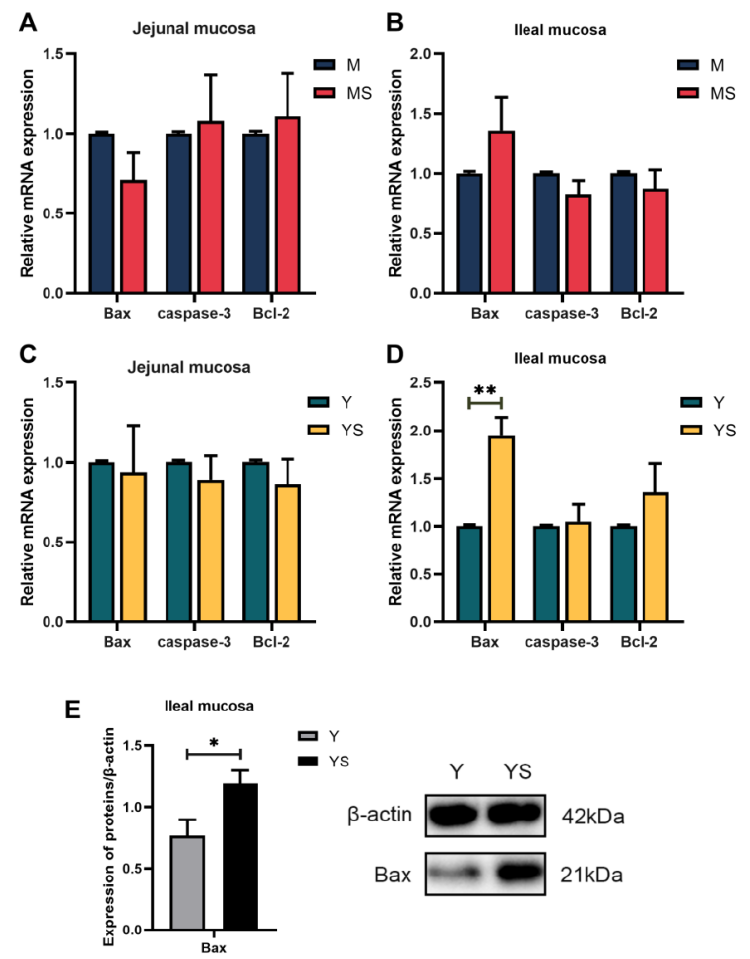
Figure 5. Effects of chronic cold stress on the expression of key genes and proteins in the apoptotic pathway of pig intestinal mucosa. ( A , B ) The mRNA expression of key genes of apoptosis in intestinal mucosa of Min pigs (n = 6). ( C , D ) The mRNA expression of key genes of apoptosis in intestinal mucosa of Yorkshire pigs (n = 6). ( E ) The protein expression level of Bax in the ileal mucosa of Yorkshire pigs (n = 6). Data are presented as the means ± SEM. * p < 0.05, ** p < 0.01.